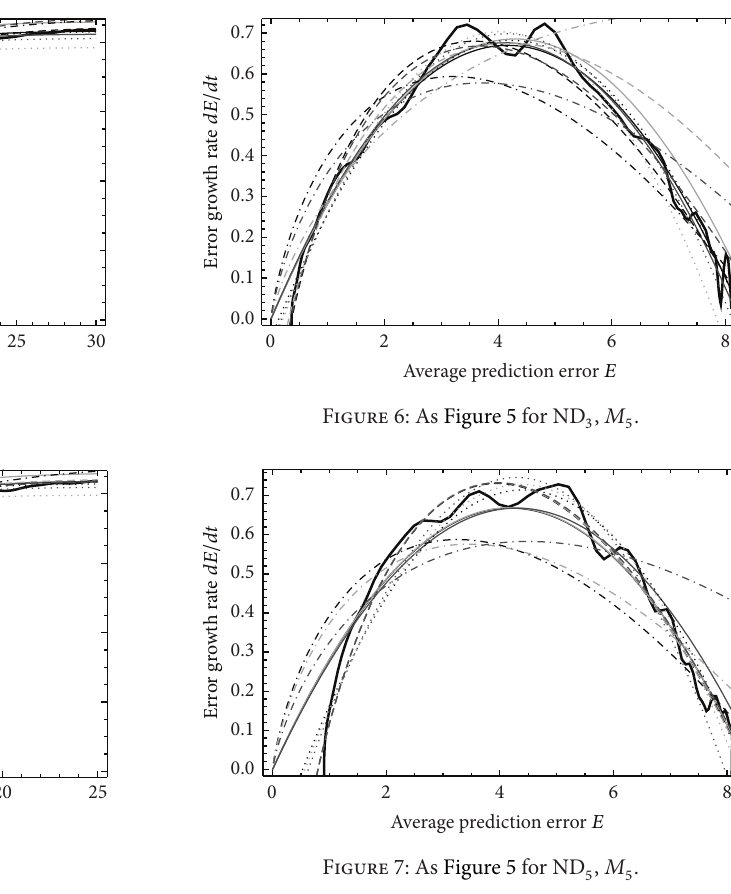
Table 3 focuses on the average values over 𝑀 1,...,5 of 𝐸 for ND 1,...,5 and average ND. This value is for exam- asym ,𝜏1,...,3 ple used to find out if the variability of the model is equal